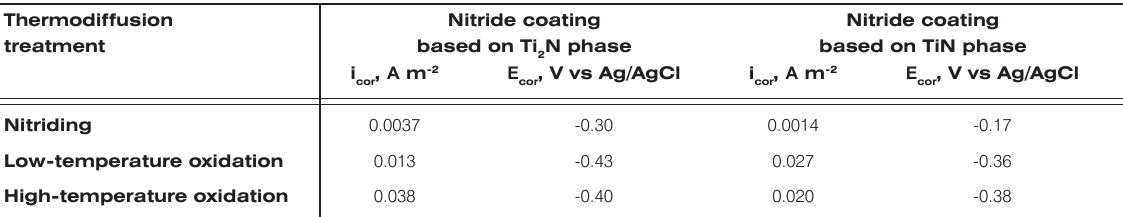
Table 1. Corrosion parameters of Ti-6Al-4V alloy in 0.9 % NaCl at 40 o C after thermodiffusion